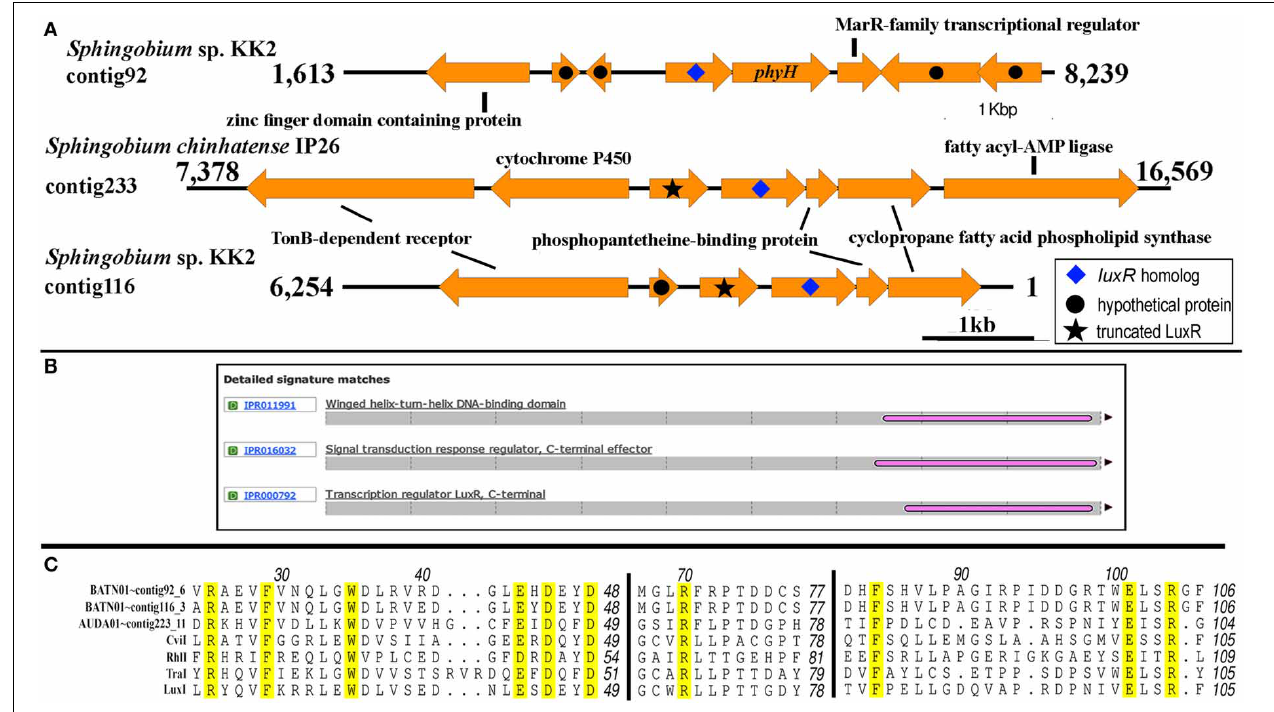
FIGURE 7 | Genomic and genetic evidence for the presence of luxI solos in sphingomonads. (A) Gene neighborhood showing non- LuxR genes located in the vicinity of the putative LuxI genes (arrow with blue diamond). Analysis of the translated protein sequence for the gene upstream and convergently oriented to the putative luxI gene in Sphingobium chinhatense IP26 and Sphingobium sp. KK2 indicates that it may be an N-terminal